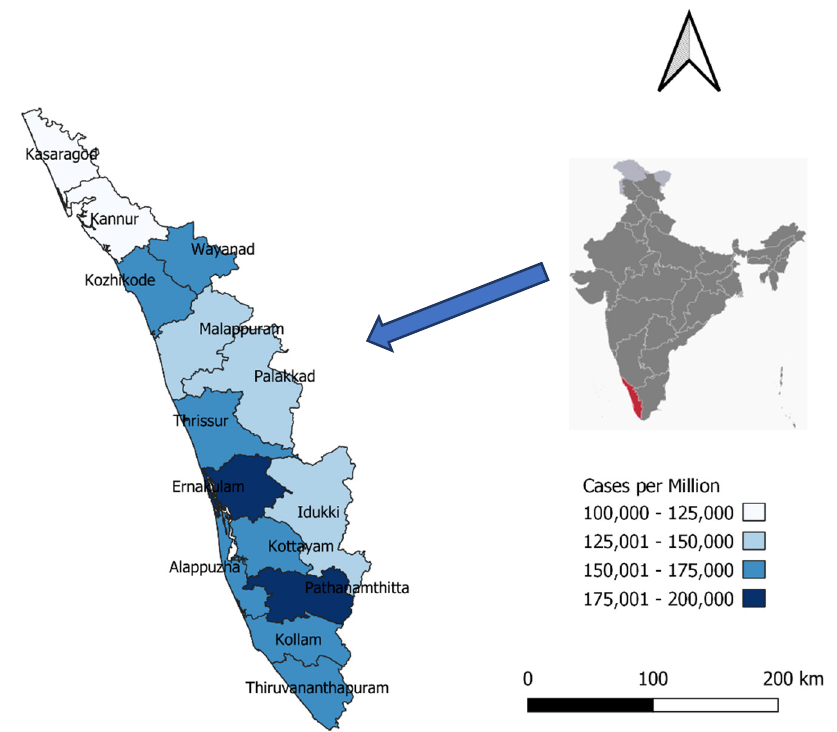
Figure 3. COVID-19 cases per million in the 14 districts of Kerala over the two-year period, 2020–2021.